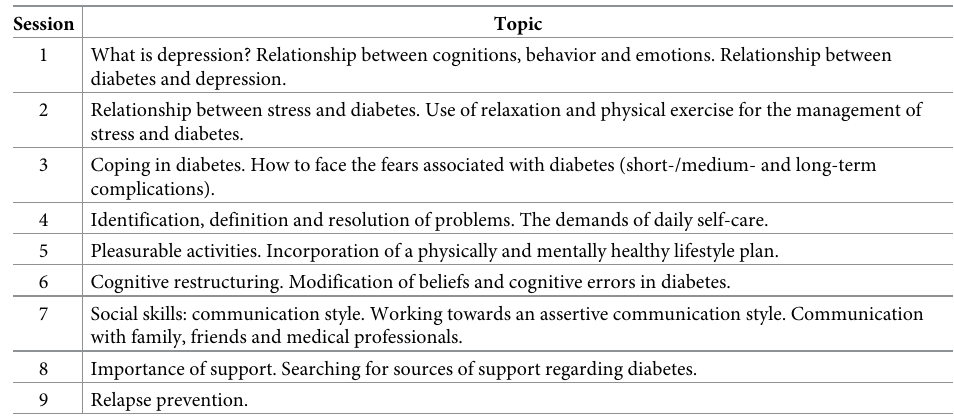
Table 1. Treatment sessions. Session Topic 1 What is depression? Relationship between cognitions, behavior and emotions. Relationship between diabetes and depression. Relationship between stress and diabetes. Use of relaxation and physical exercise for the management of stress and diabetes. Coping in diabetes. How to face the fears associated with diabetes (short-/medium- and long-term complications). Identification, definition and resolution of problems. The demands of daily self-care. Pleasurable activities. Incorporation of a physically and mentally healthy lifestyle plan. Cognitive restructuring. Modification of beliefs and cognitive errors in diabetes. Social skills: communication style. Working towards an assertive communication style. Communication with family, friends and medical professionals. Importance of support. Searching for sources of support regarding diabetes. Relapse